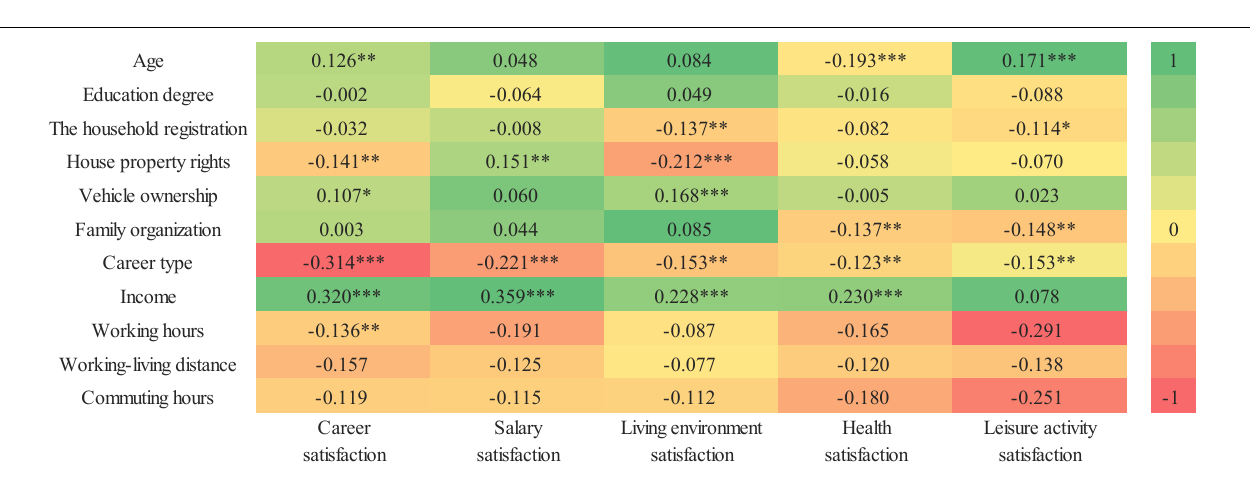
and working hours ( β = –0.136, p < 0.05) was